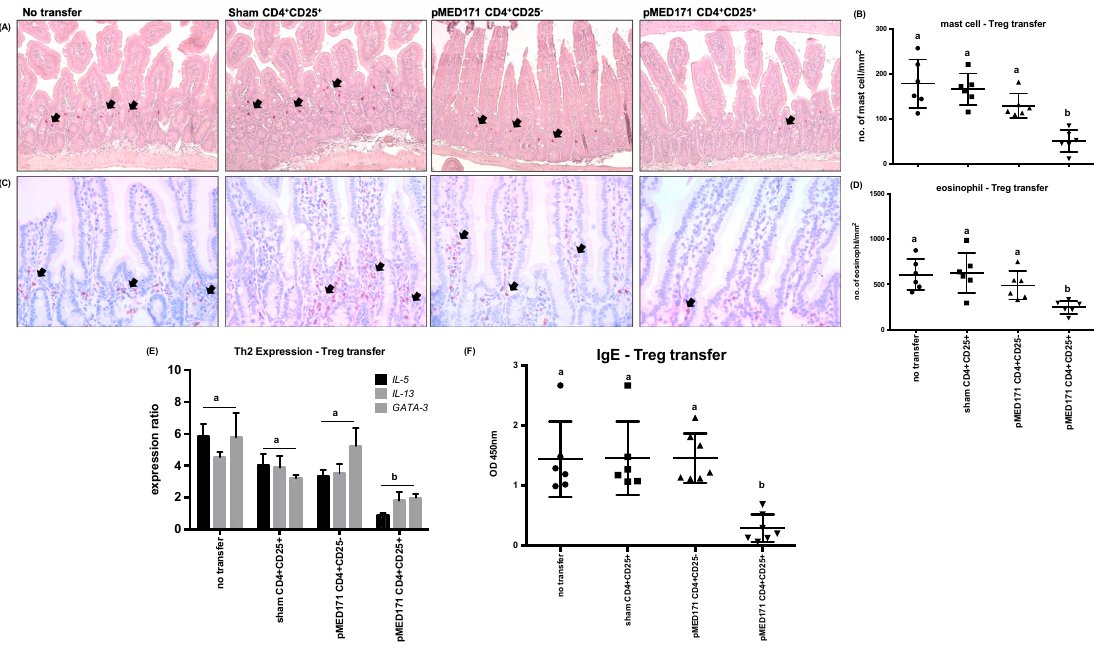
Figure 5. Immunological responses with Treg cell transfer. ( A ) Representative photomicrographs of mast cells (arrows indicate mast cells stained red in chloroacetate esterase staining; magnification = 200X). ( B ) Quantification of mast cells per mm 2 of crypt area. ( C ) Representative photomicrographs of anti-MBP-stained eosinophils (arrows indicate eosinophils stained brown in IHC; magnification = 400X). ( D ) Quantification of eosinophils per mm 2 of villus. ( E ) Local expression of Th2 cytokines and transcription factors in the small intestine detected by qPCR and ( F ) levels of serological tropomyosin-specific IgE measured by ELISA. Note that only the transfer of CD4 + CD25 + Treg cells from pMED171-treated donors led to significant reduction in intestinal inflammation, Th2 responses, and allergen-specific IgE titer. Data are shown as individual data points denoted by different symbols for each experimental group with mean ± SD. Statistical differences among different experimental groups were determined by Bonferroni post-test after one-way ANOVA; groups denoted by the same alphabet are not significantly different, while those denoted by different alphabets are statistically different ( p < 0.05).